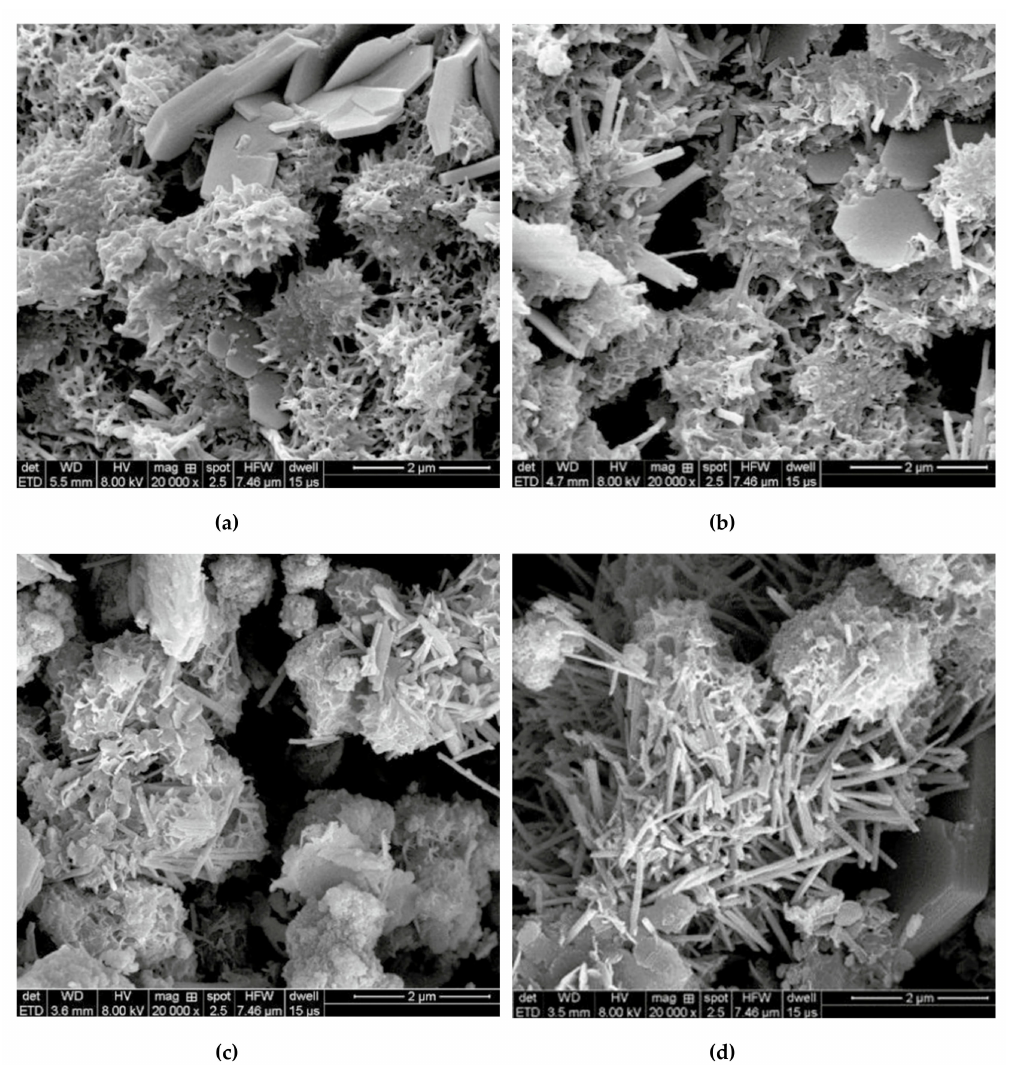
Figure 11. SEM images of cement samples with addition of 2 wt.% nano-TiO 2 cured under temperatures of ( a ) 0 ◦ C, ( b ) 5 ◦ C, ( c ) 10 ◦ C, and ( d ) 20 ◦ C at 28 days. Reprinted with permission from [97]. Copyright © 2018,